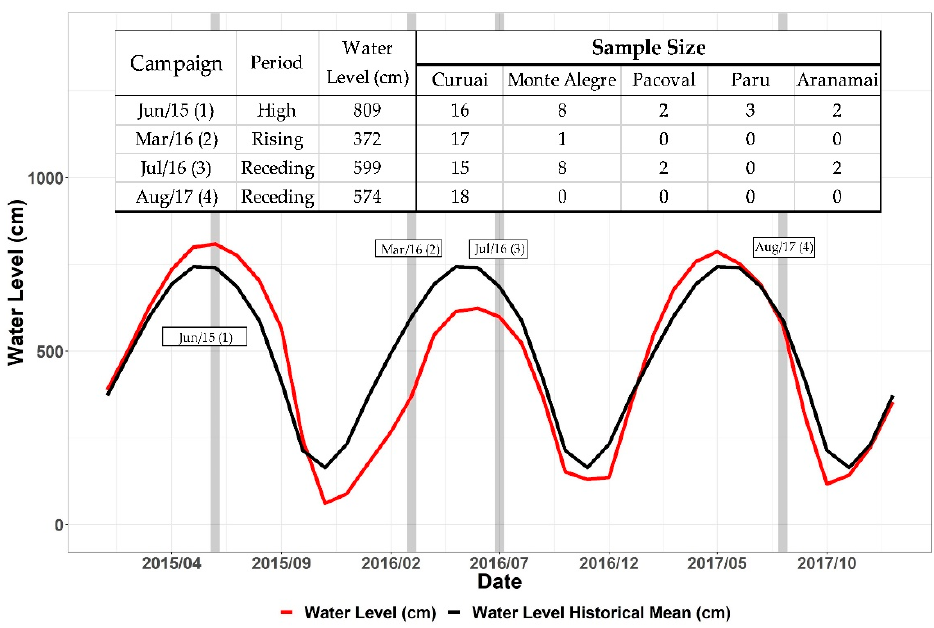
Figure 2. A hydrograph at Óbidos Fluviometric station (red line), the historical mean at Óbidos Fluviometric station (1968–2018) (black line), and the sample size for each field campaign: The grey vertical lines indicate the beginning of the field mission in each campaign.